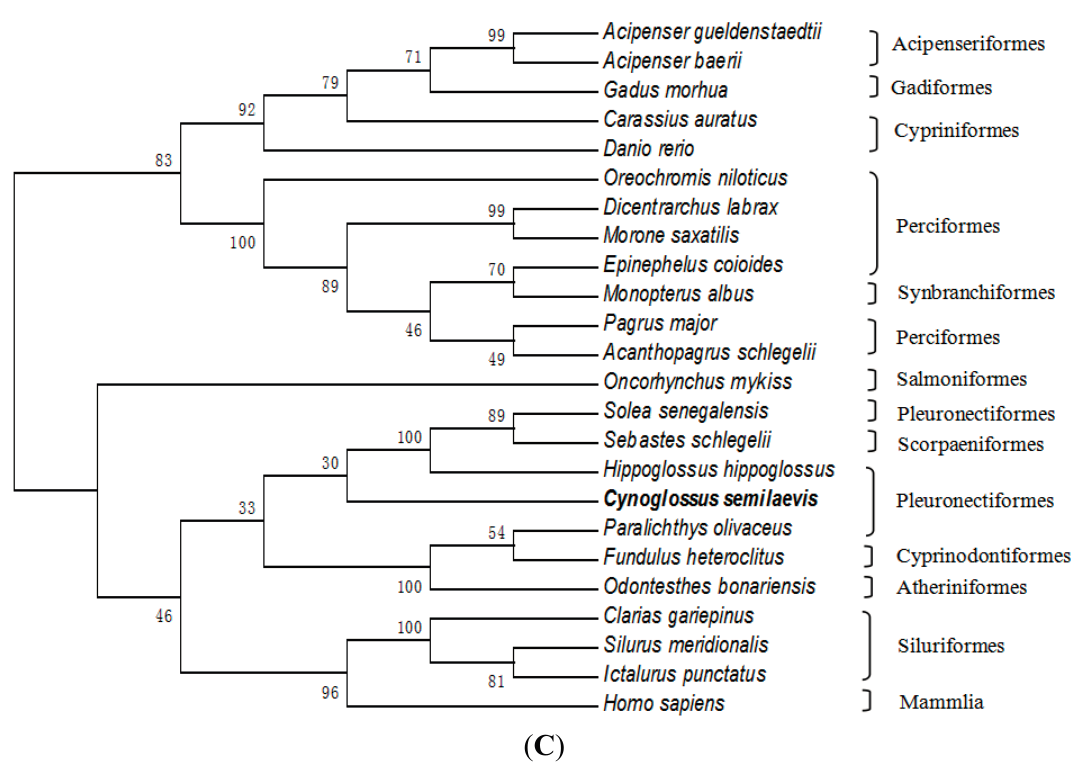
Figure 5. Phylogenetic tree based on the amino acid sequences of FSH β ( A ), LH β ( B ) and CG α ( C ) from vertebrate. The tongue sole FSH β , LH β and CG α are highlighted by boldface. Bootstrap values (%) are indicated by 1000